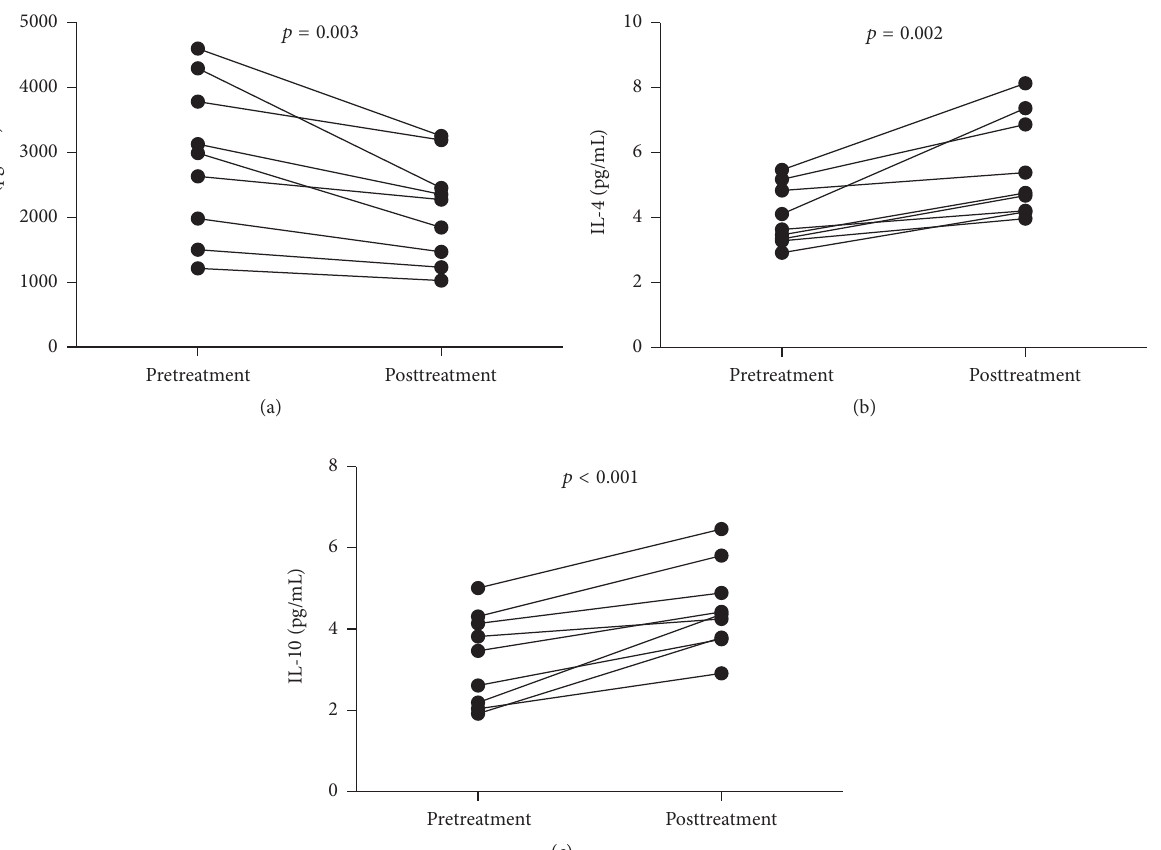
Figure 7: Levels of serum cytokines in IgAN patients following treatment. The concentrations of serum cytokines were compared in IgAN patients before and after treatment. The data are expressed as the mean % or concentration of individual subjects from two divided experiments. ((a)–(c)) The levels of serum of sST2, IL-4, and IL-10 in individual patients pre- and posttreatment,